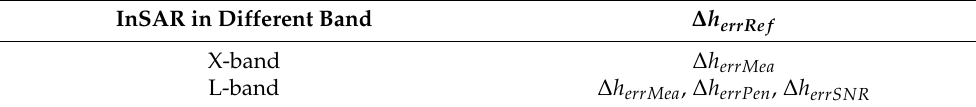
Table 1. The composition of ∆ h errRef in the X and L